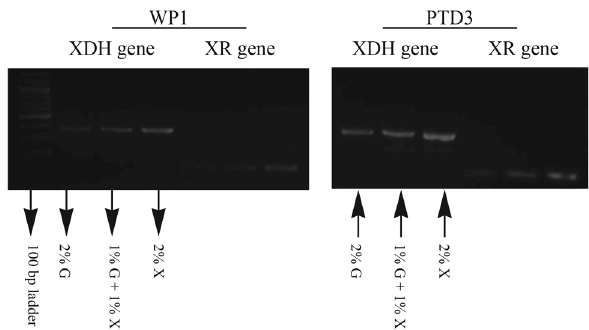
Table 2 - XR and XDH identities between homologous proteins in several yeast strains a . Identity WP1 Pichia